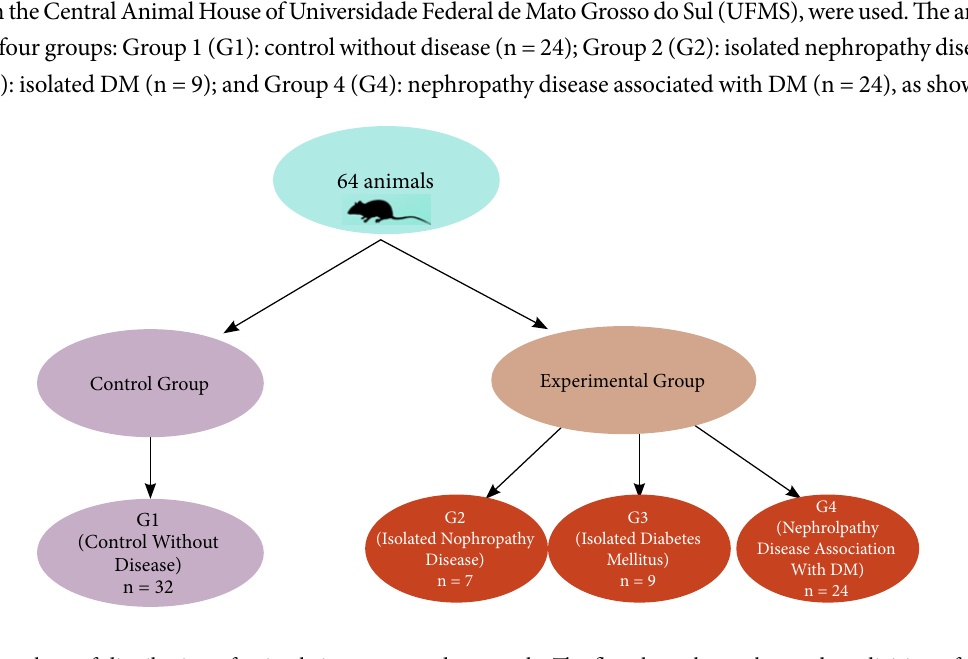
Figure 1 – Flowchart of distribution of animals in groups and protocols. The flowchart shows the random division of animals into groups: G1 (healthy control without disease); and the experimental group subdivided into G2 (isolated nephropathy disease); G3 (isolated DM); and G4 (nephropathy disease associated with